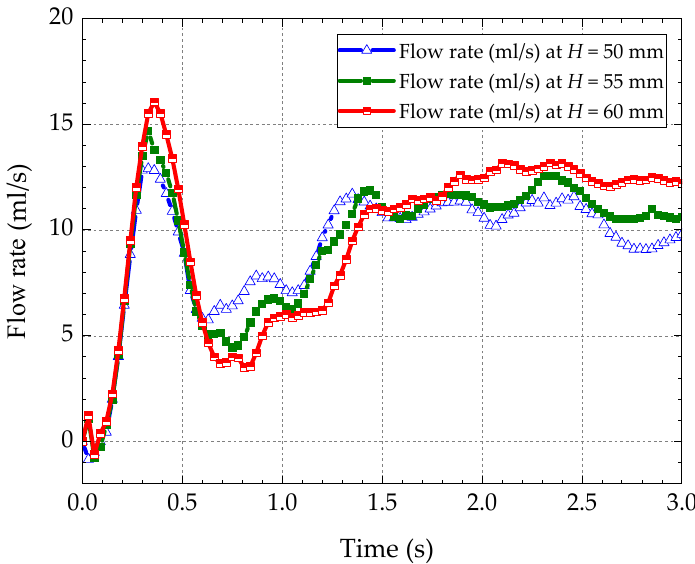
Figure 14. Change rules of flow rate moment versus time (Monitoring Plane 3).